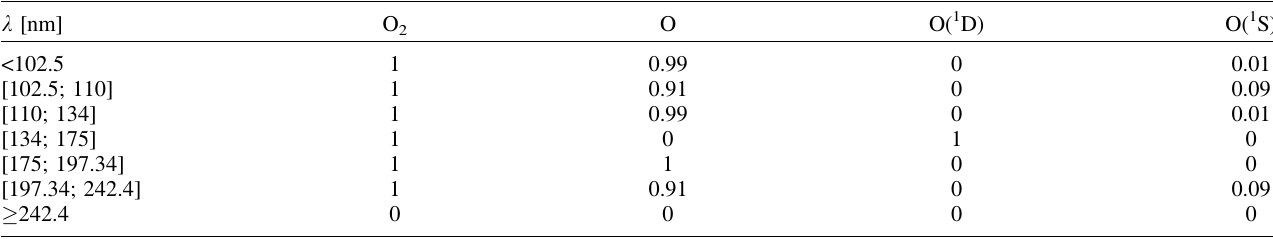
Table A.3. Quantum yields selected for the O 2 photodissociation (from Moreels et al., 1977). k [nm]